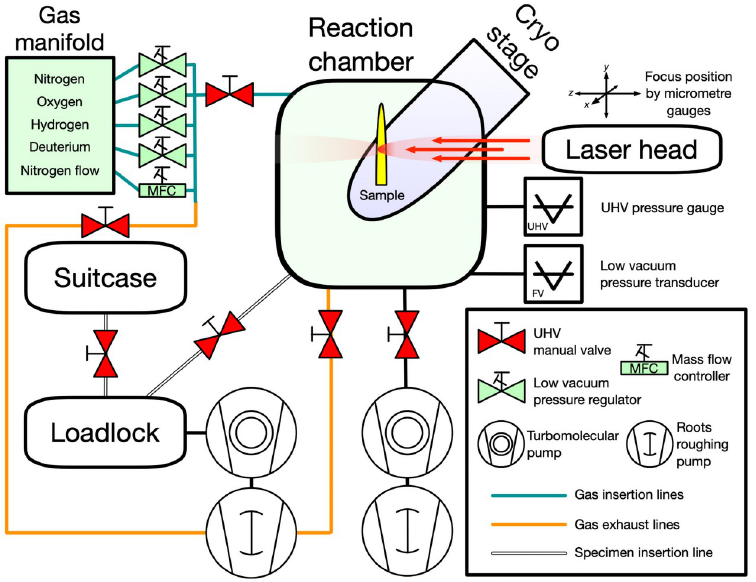
Fig 2. Reacthub schematic. The Reacthub consists of an ultrahigh vacuum chamber with a cryostage holding the specimen, an infrared laser which heats the specimen’s immediate mounting, and a manifold for controlled filling of particular